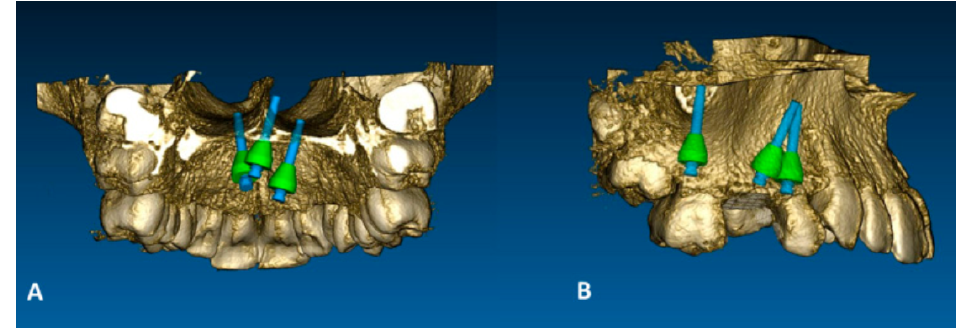
Figure 5. Bushings and miniscrews positioned in the patient CBCT. ( A ) Posterior view ( B ) Lateral view. Bushings and miniscrews are positioned in such a way to achieve miniscrew bicortical anchor- age (engagement of cortical bone of oral cavity vault and nasal floor). Also, they are not parallel and preferably diverge